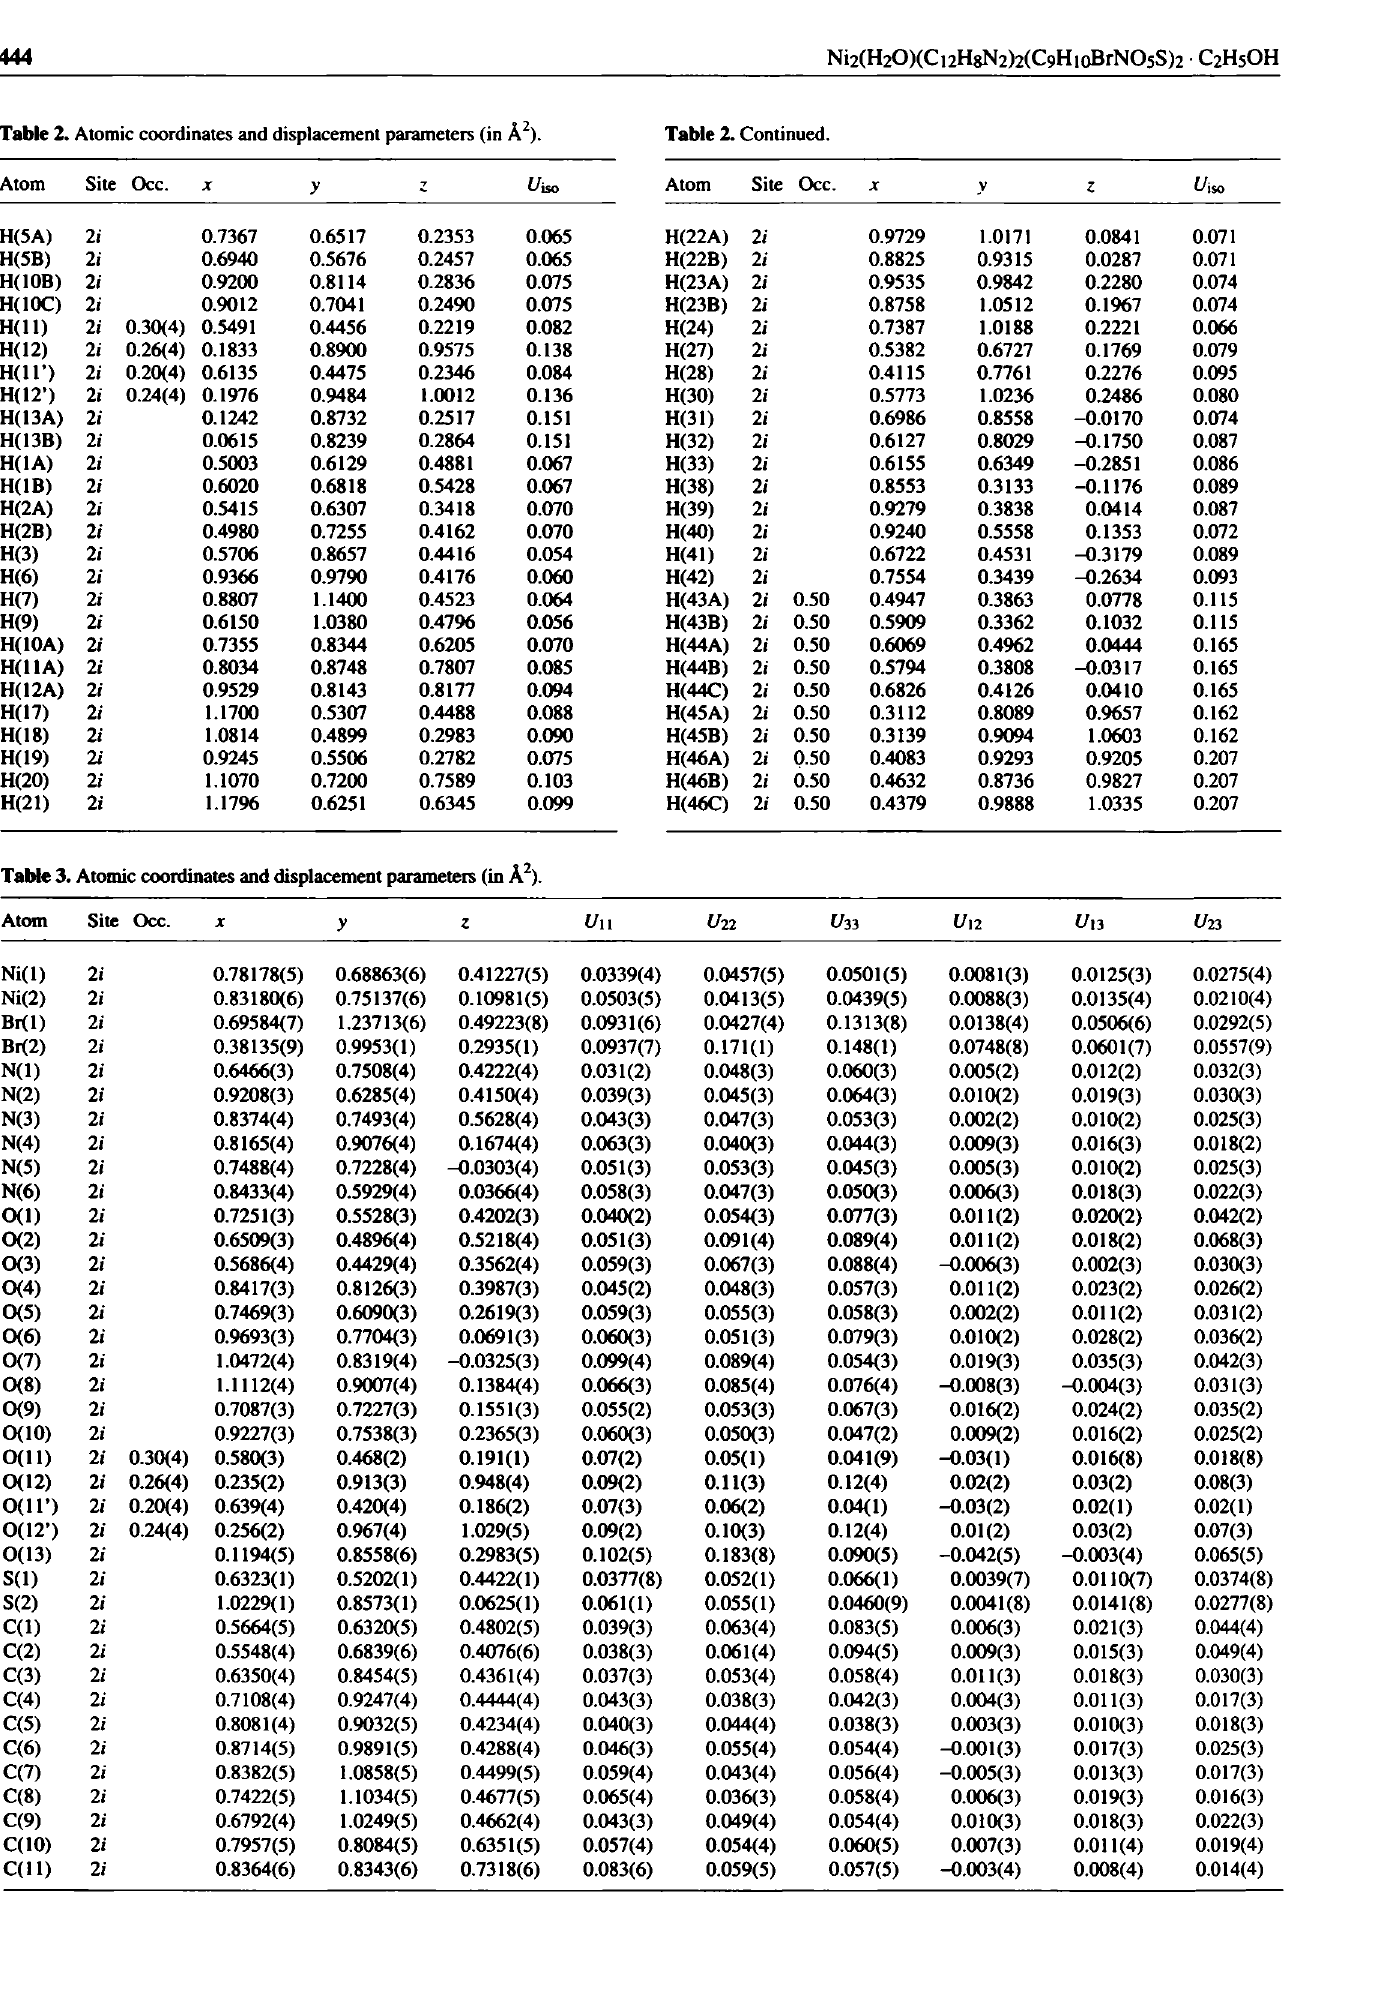
Table 3. Atomic coordinates and displacement parameters (in Â 2